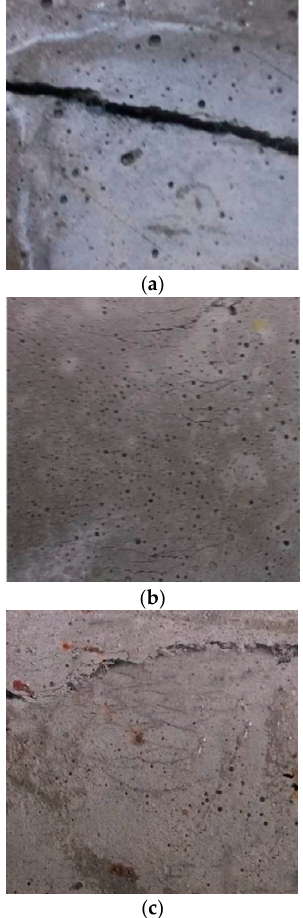
Figure 15. Failure mode of matrix [76]. ( a ) Mortar, ( b ) oil-coated PVA, and ( c ) PVA coated without oil.